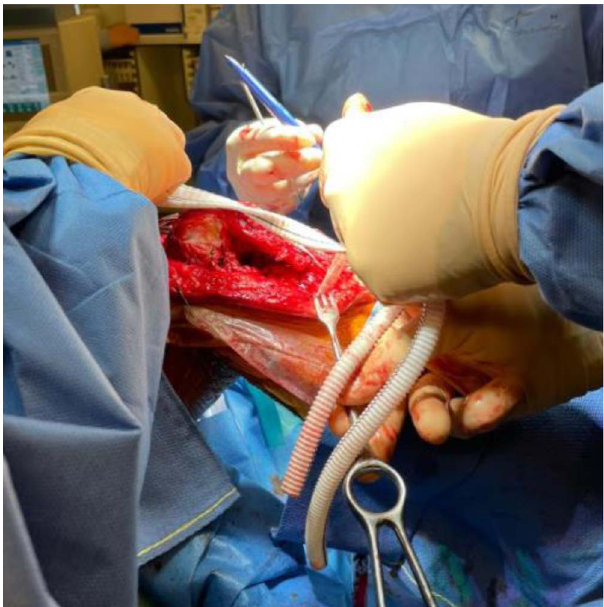
Figure 12. Performing the square knot between both ends of the bifurcation.